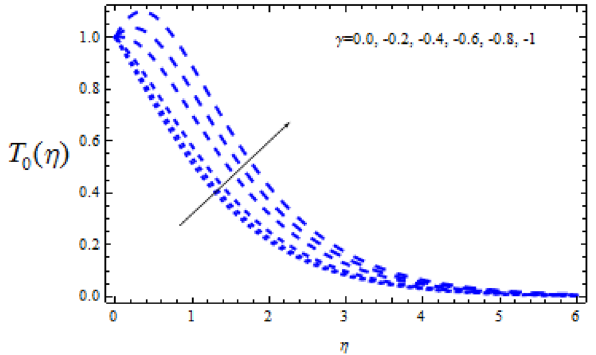
Figure 20. Consequence of ϒ on T 0 (η) .